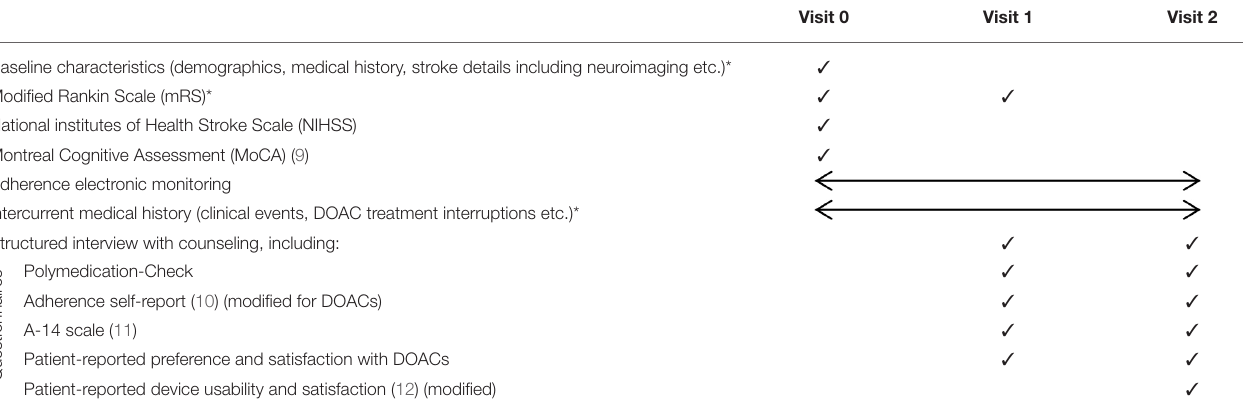
TABLE 1 | Assessments